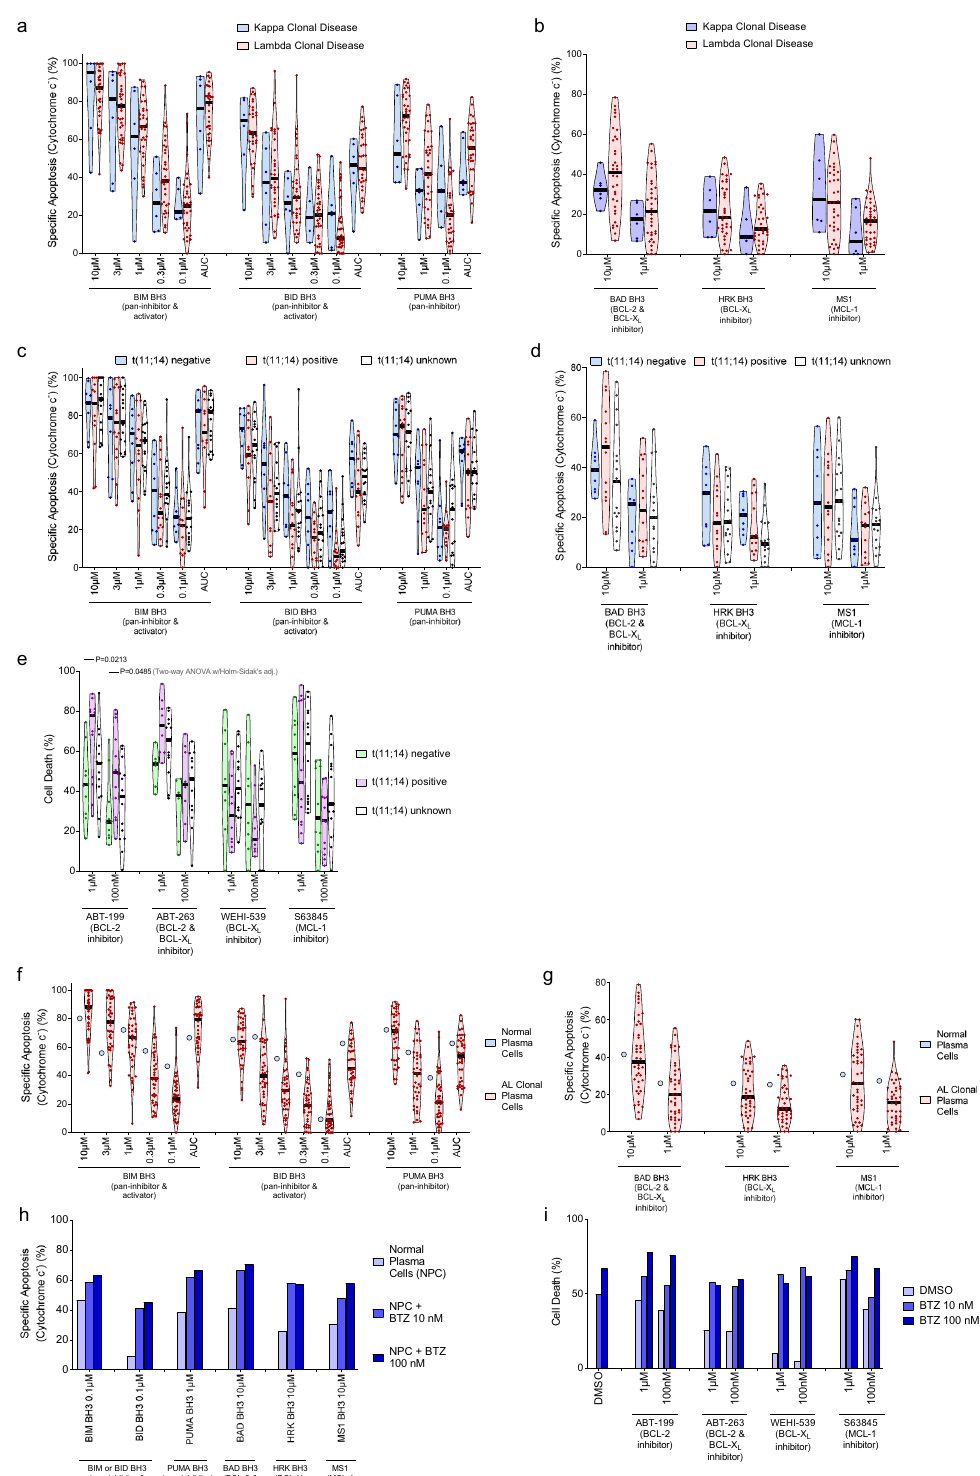
e exvivosensitivitytoBH3mimetics. f , g BH3pro fi lingCD138+cellsfromahealthy bone marrow donor showing ( f ) overall priming and g dependencies on pro- survival proteins compared to clonal AL CD138+cells. h Dynamic BH3 pro fi ling of normalplasmacellstreatedwithbortezomibfor12h. i Exvivosensitivityofnormal plasma cells to the combination treatment of bortezomib with indicated BH3 mimetics. P -values were calculated using two-way ANOVA with Holm – Sidak ’ s adjustment for e